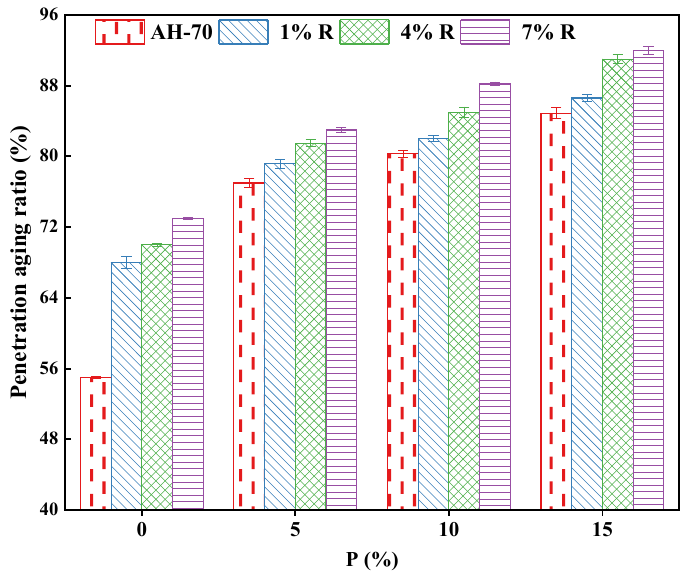
Figure 8. Penetration aging ratio.